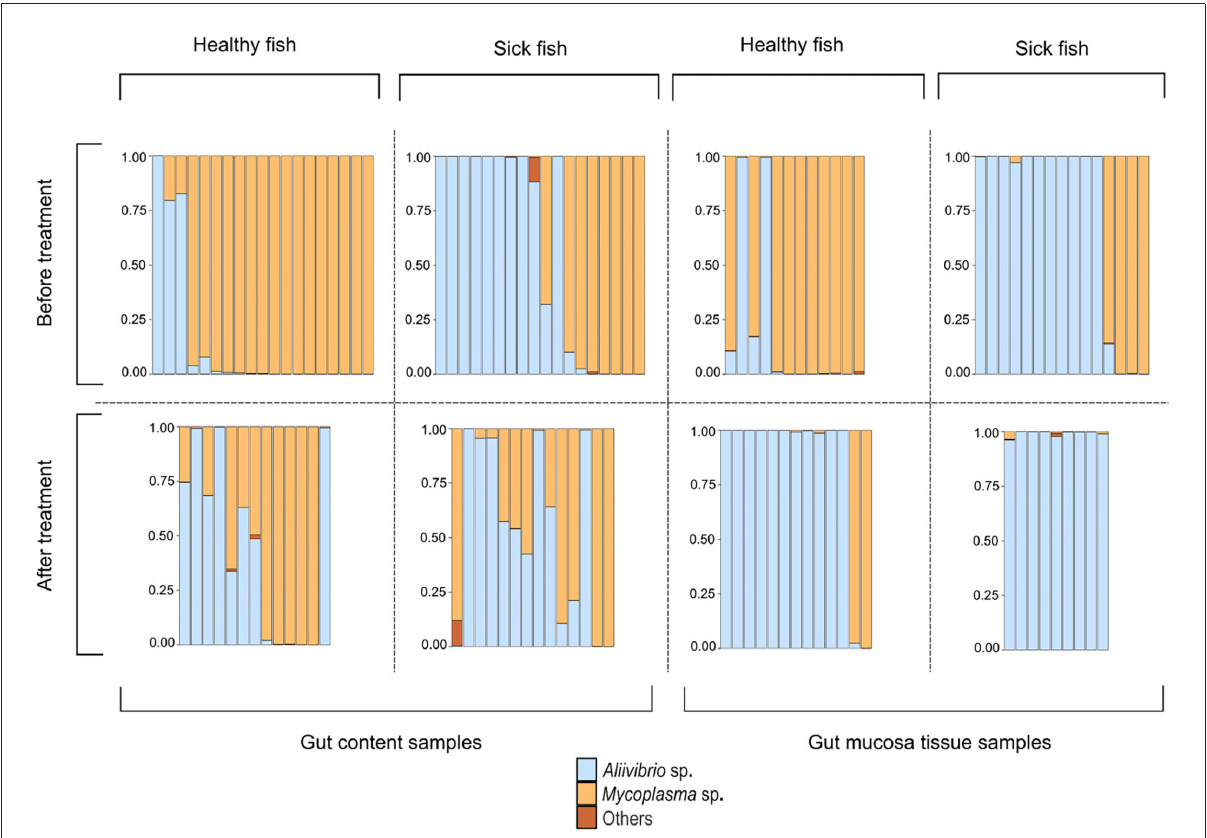
FIGURE1 Intestinal microbiota composition for the two dominant bacterial species Mycoplasma sp. and Aliivibrio sp. for eight distinct cohorts of Atlantic salmon during a disease outbreak. Each bar represents one fish. The eight cohorts represent three relevant variables pertaining to the sampled tissue (gut content vs. gut mucosa), the health status during a Tenacibaculosis outbreak (Healthy vs. Sick), and whether fish were sampled before or after treatment against the Tenacibaculosis causing pathogen Tenacibaculum dicentrarchi (before vs. after treatment). The figure has been reformatted based on data from Bozzi et al.